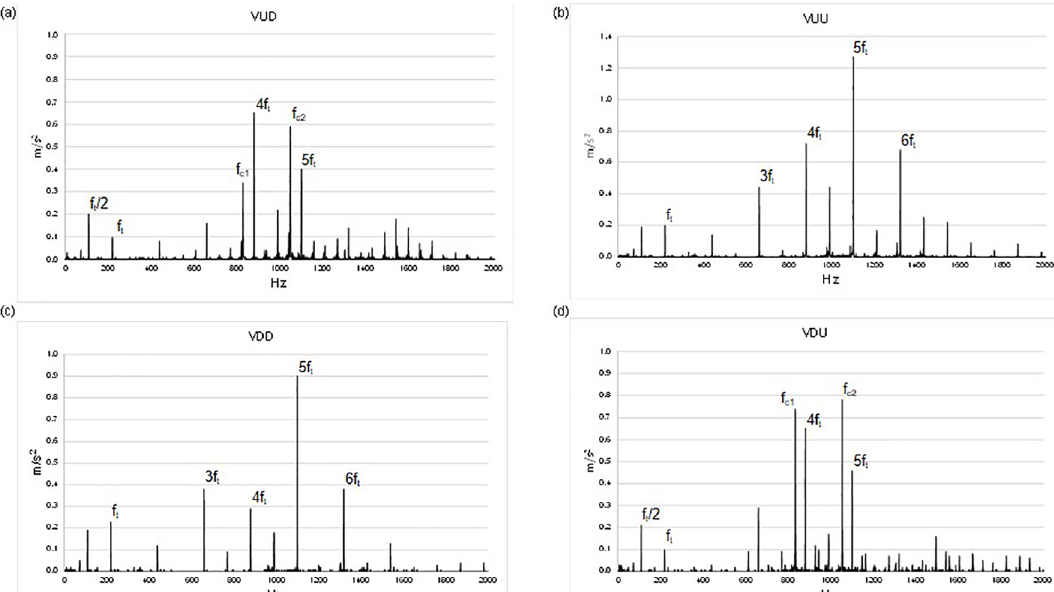
Figure 3. Spectrum of the acceleration signals for vertical tool path orientations at inclined workpiece angle of 15º (a) VUD, (b) VUU, (c) VDD, (d) VDU